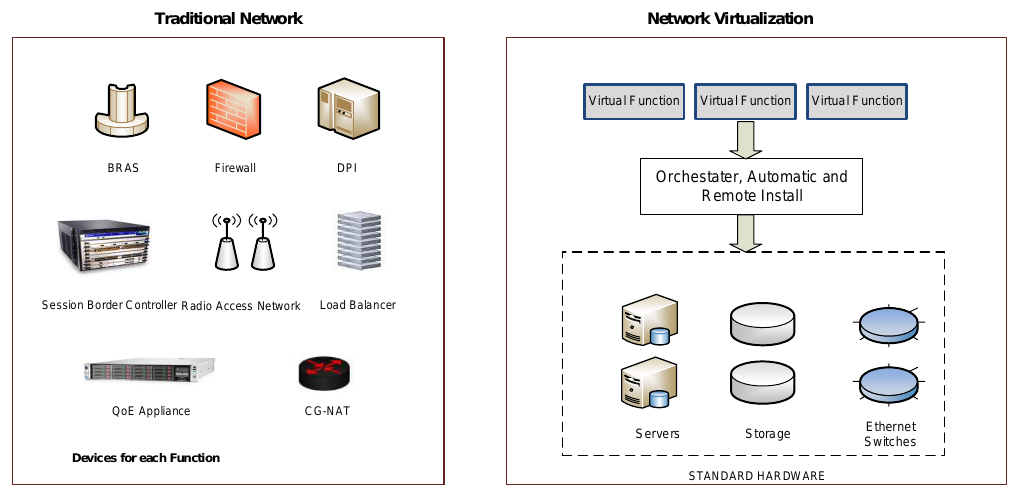
Figure 2. Traditional Network Functions vs. Virtual Network Functions.